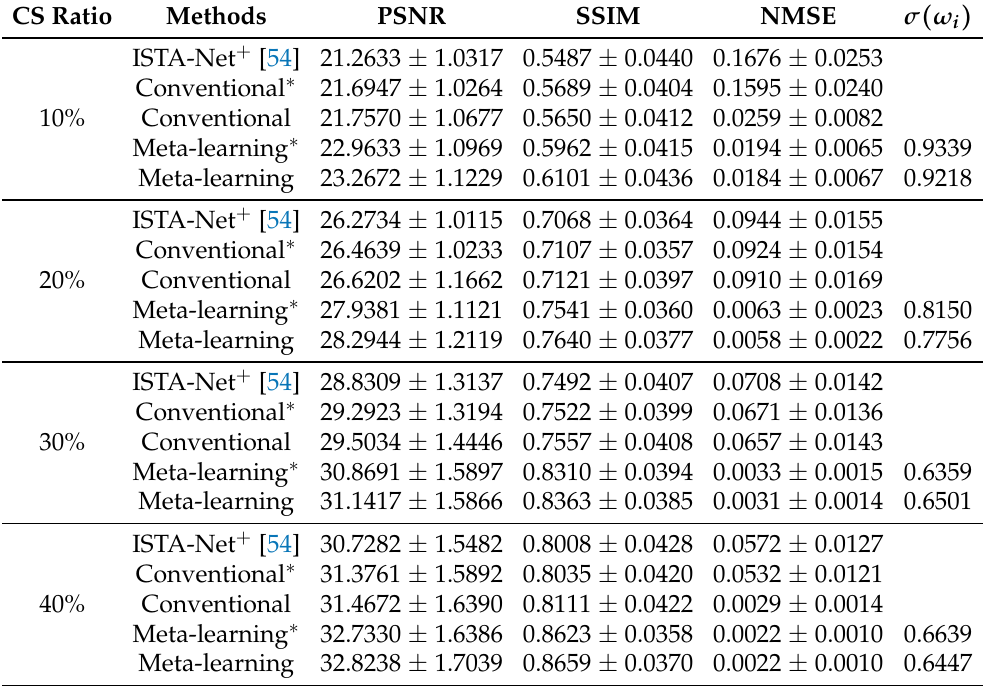
Table 1. Quantitative evaluations of the reconstructions of T1 brain image associated with various sampling ratios of radial masks. Conventional ∗ and meta-learning ∗ are trained with two-thirds of the dataset used in training conventional and meta-learning approaches, respectively.